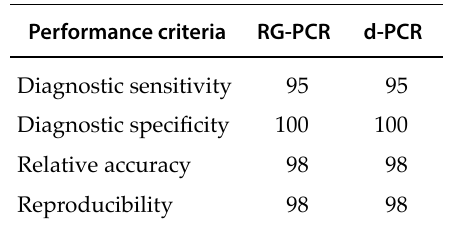
Table 3. Performance criteria for detection of Pseudomonas syring e pv. actinidiae obtained by specific PCR (RG-PCR: Rees-George et al ., 2010; d-PCR: Gallelli et al ., 2011a) on DNA extracted from pollen, leaf and wood samples by DNeasy plant mini kit (Qiagen) (direct-PCR). All values were expressed in percentages (%).